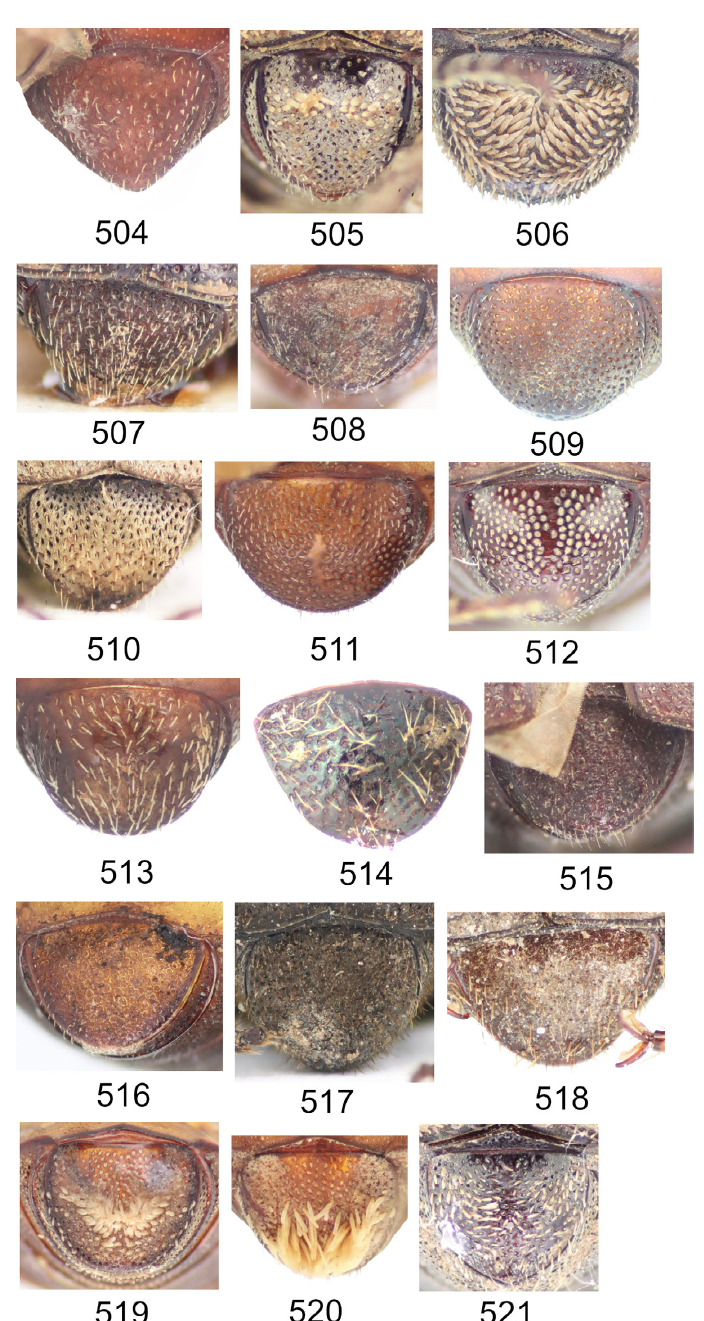
Figs 504–521. Papuan and Wallacean Maechidius Macleay, 1819, pygidium, dorsal view. 504 . M. paupianus Heller, 1910, lectotype, ♀ (SNSD). 505 . M. pauxillus Heller, 1910 comb. rest., lectotype, ♂ (SNSD). 506 . Same, ♀ (BMNH). 507 . M. pedarioides Arrow, 1941, syntype, ♀ (BMNH). 508 . Same, syntype, ♂ (BMNH). 509 . M. peregrinus Lansberge, 1886, ♂ (DTC). 510 . M. perlatus (Frey, 1969) comb. nov., ♂ (SMNS). 511 . M. popei (Frey, 1969) comb. nov., holotype, ♀ (BMNH). 512 . Same, paratype, ♂ (BMNH). 513 . M. riedeli sp. nov., holotype, ♂ (SMNS). 514 . M. rugicollis Moser, 1920, ♂ (BMNH). 515 . M. seriegranosus Heller, 1914, lectotype, ♂ (SNSD). 516 . M. similis sp. nov., paratype, ♂ (BMNH). 517 . M. skalei sp. nov., paratype, ♂ (NME). 518 . M. sougb sp. nov., holotype, ♂ (NME). 519 . M. speciosus (Frey, 1969) comb. nov., ♂ (BMNH). 520 . Same, different ♂ (BMNH). 521 . Same, ♀ (BMNH). Not to